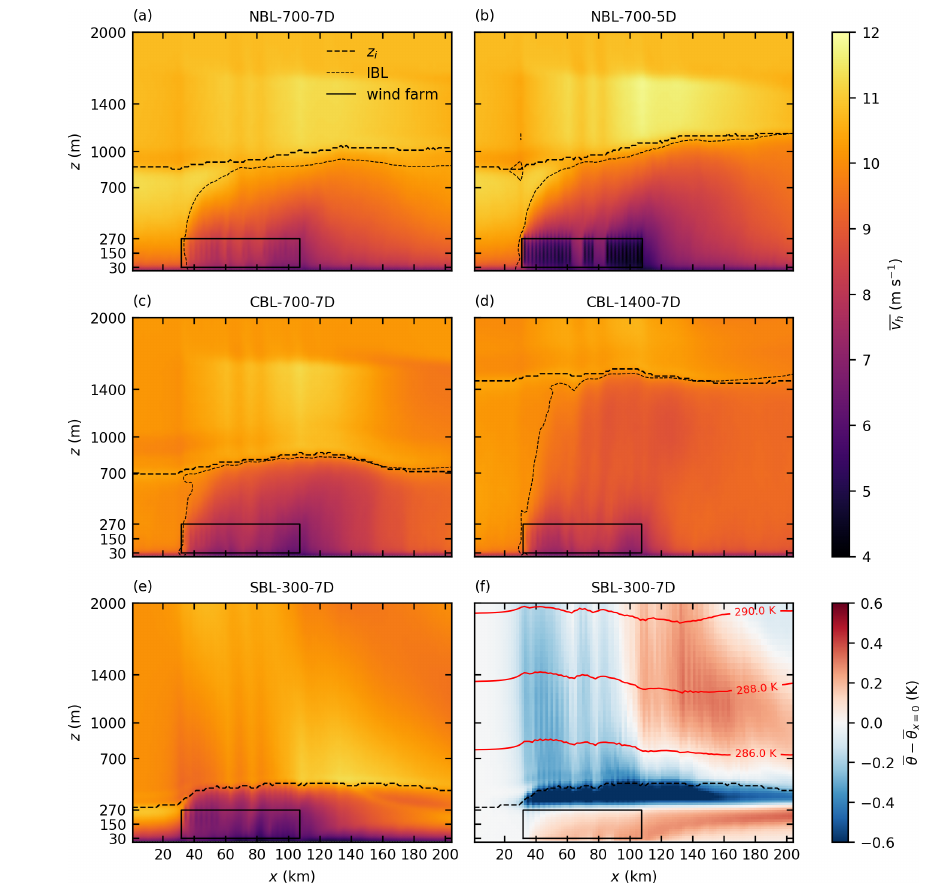
Figure 7. Vertical cross sections at y = 120km of wind speed v h for all cases (a–e) and potential temperature deviation relative to the inflow temperature for the case SBL-300-7D (f) . Also shown are the inversion layer height z i (maximum vertical temperature gradient), the internal boundary layer IBL (97% of inflow wind speed) and the extent of the wind farms in Zone